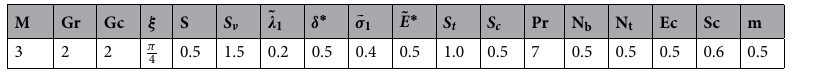
Table 2. Default values of emerging parameters.